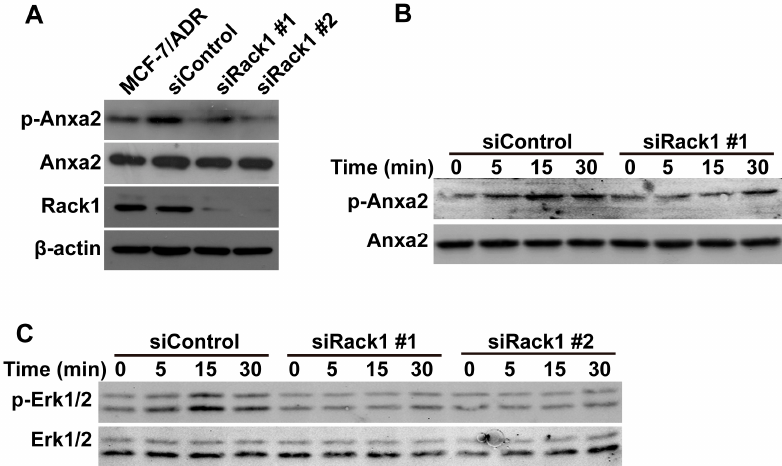
Figure 5. Knockdown of Rack1 inhibits Anxa2 phosphorylation and adriamycin induced Erk1/2 phosphorylation. ( A ) Western blotting analysis of Anxa2 and tyrosine phosphorylated Anxa2 expression in MCF-7/ADR cells transfected with control or Rack1 specific stealth siRNAs; ( B ) Silencing of Rack1 inhibited adriamycin induced phosphorylation of Anxa2 in MCF-7/ADR cells. Control and Rack1 knockdown cells were starved for 24 h and then exposed with 0.5 µ M adriamycin for different time points, then cells were lysed, and total cell lysate was further analyzed by Western blotting; ( C ) Downregulation of Rack1 inhibited adriamycin-induced phosphorylation of Erk1/2 in MCF-7/ADR cells. Western blotting analysis of adriamycin-induced phosphorylation of Erk1/2 in MCF-7/ADR cells transfected with control and Rack1-specific stealth siRNAs.